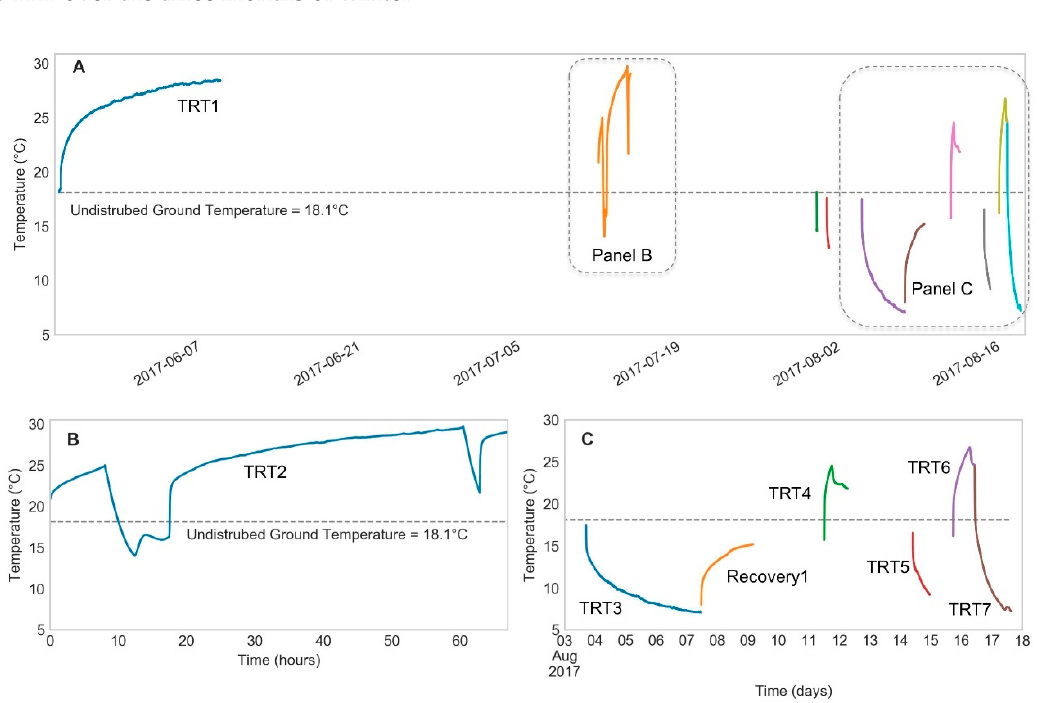
Table 2. TRTs performed and principal rest periods.